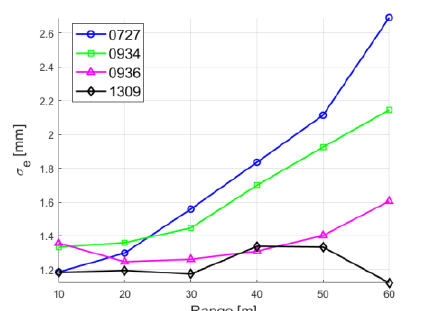
Fig. 4. Estimated noise, σ e , for the four rock samples versus